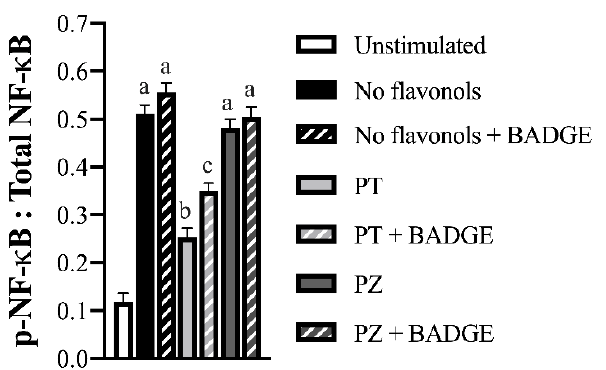
Figure 4. Activated (i.e., phosphorylated) nuclear factor kappa-light-chain-enhancer of activated B cells